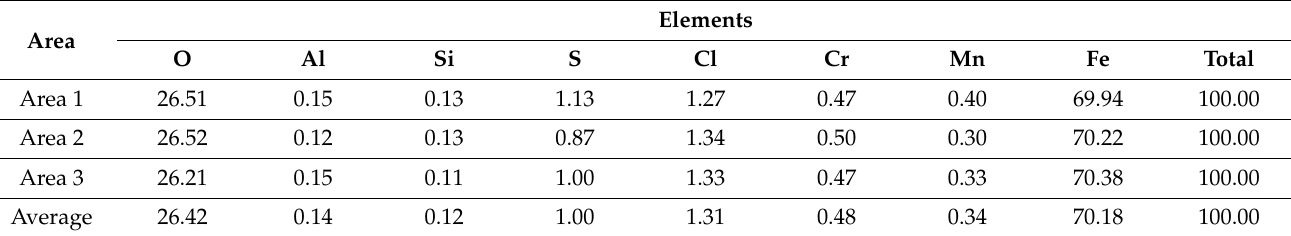
Table 1. Data of elemental analysis of magnetic composite (in